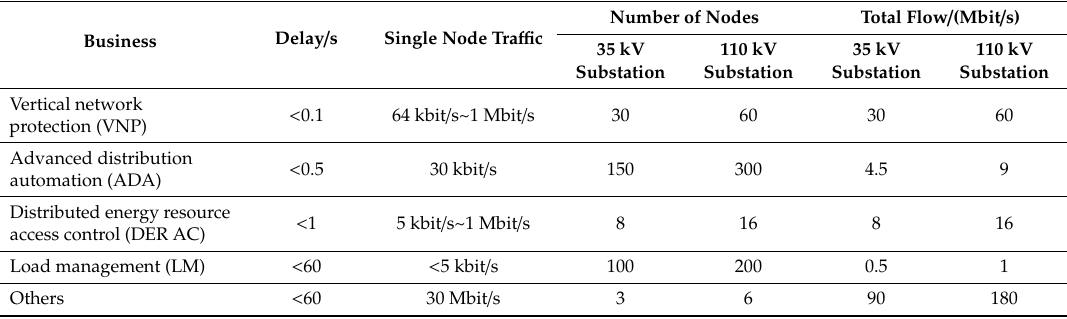
Table 1. Business tra ffi c